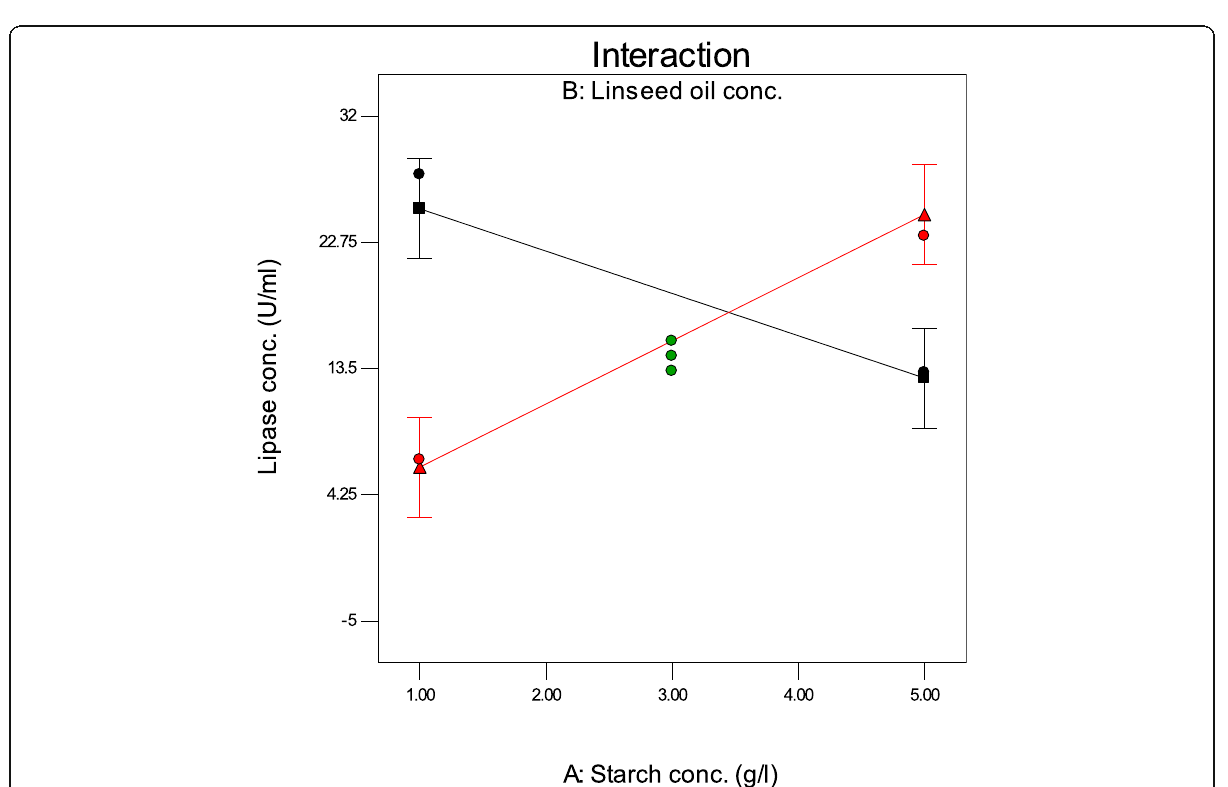
Fig. 6 The effect of starch concentration on lipase production at linseed oil levels of 1% (black-colored line) and 3% (red-colored line). Bars on the plot represent the least significant